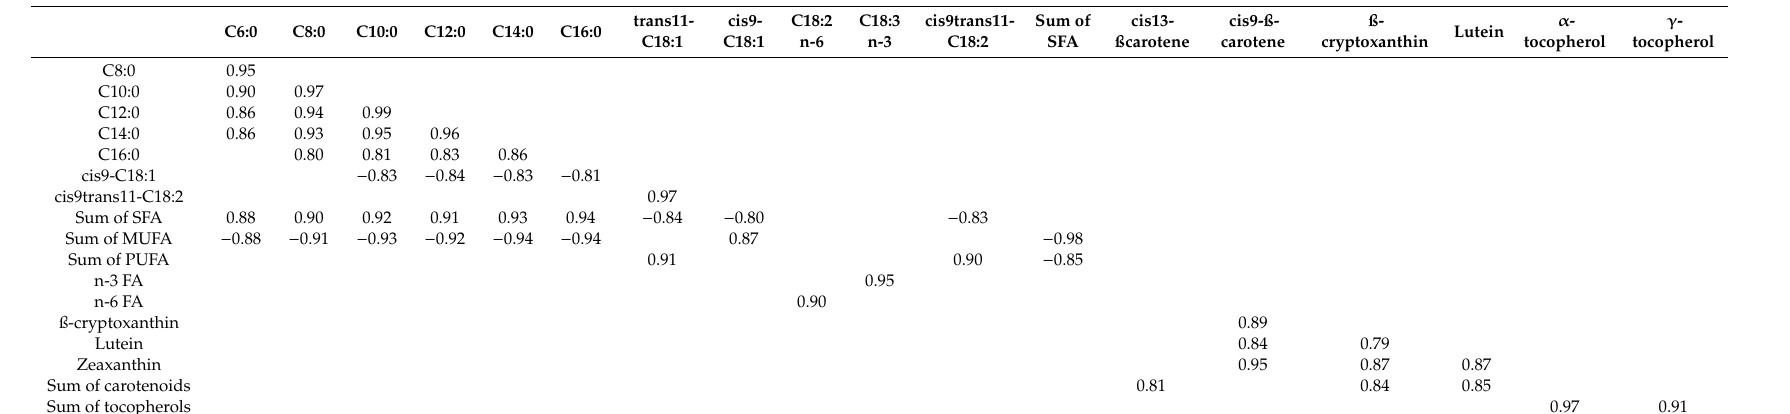
Table A4. Correlation matrix (Pearson’s correlations) between milk compounds when | r | ≥ 0.80, obtained on the calibration